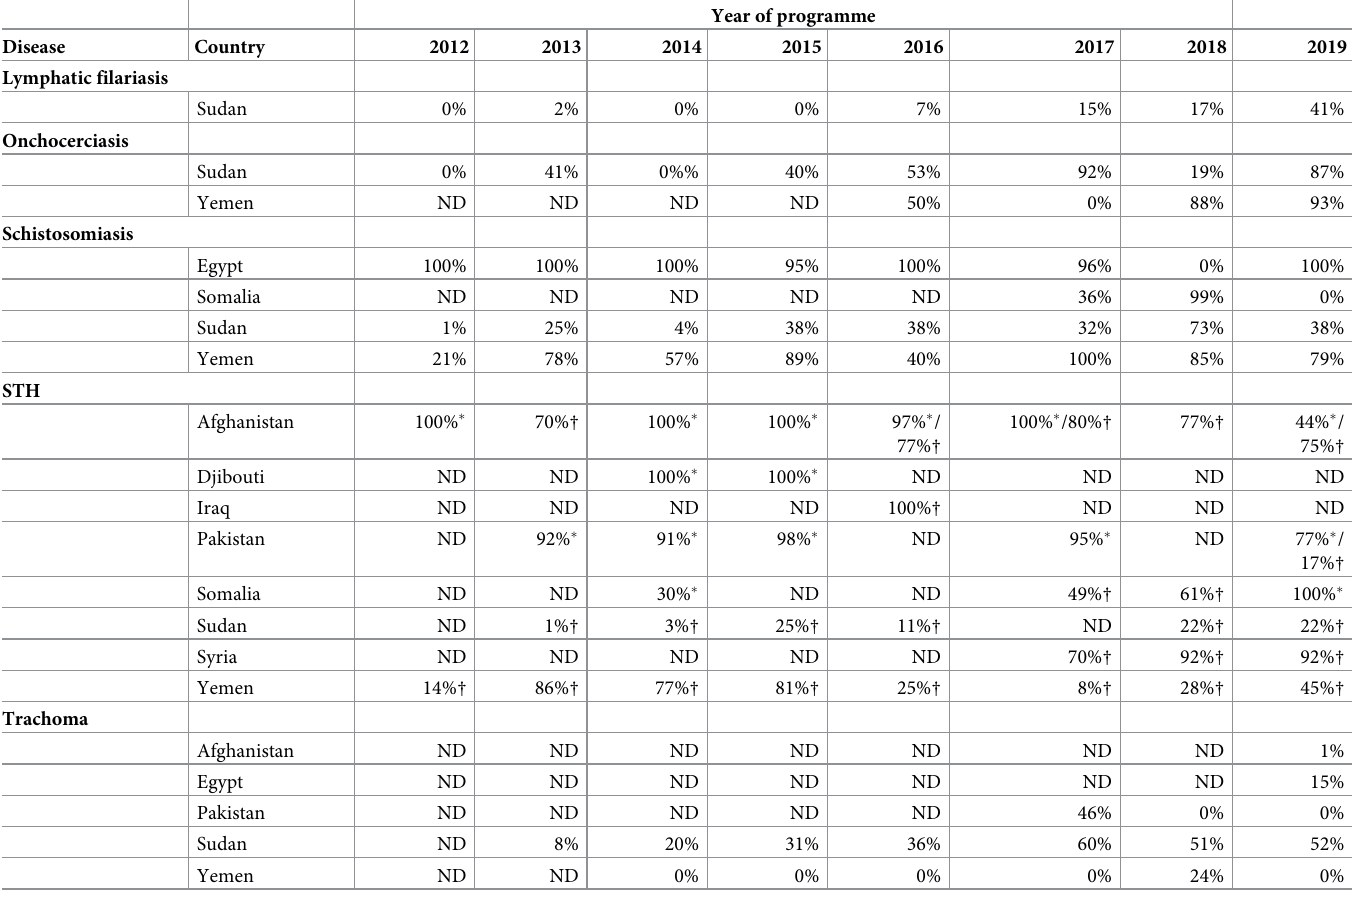
Year of programme